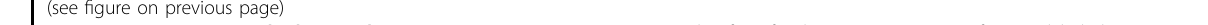
Fig. 4 TM3 MOR -TAT peptide disrupted MOR – CCKBR interaction. a An example of confocal microscopy image of 5-FAM-labeled TM3 MOR -TAT- treated HEK293 cells showing successful penetration of the TM3 MOR -TAT peptides into the cells (left). The magni fi ed area indicates the membrane location of the peptide (right). b An example of the FLIM image of TAT-fused peptide-treated cells co-expressing MOR-EGFP and CCKBR-mCherry. Compared with the untreated or scrambled-TAT-treated group, EGFP in the TM3 MOR -TAT-treated cells showed longer lifetime of fl uorescence. c Statistics of EGFP fl uorescence lifetime in ( b ). d FRET ef fi ciency of MOR-EGFP and CCKBR-mCherry in interfering peptide-treated cells. Compared with the non-peptide-treated or scrambled-TAT-treated group, the TM3 MOR -TAT-treated group exhibited a signi fi cant decrease in FRET ef fi ciency. * p < 0.05, ** p < 0.01, t- test. Data are represented as the mean ± SEM